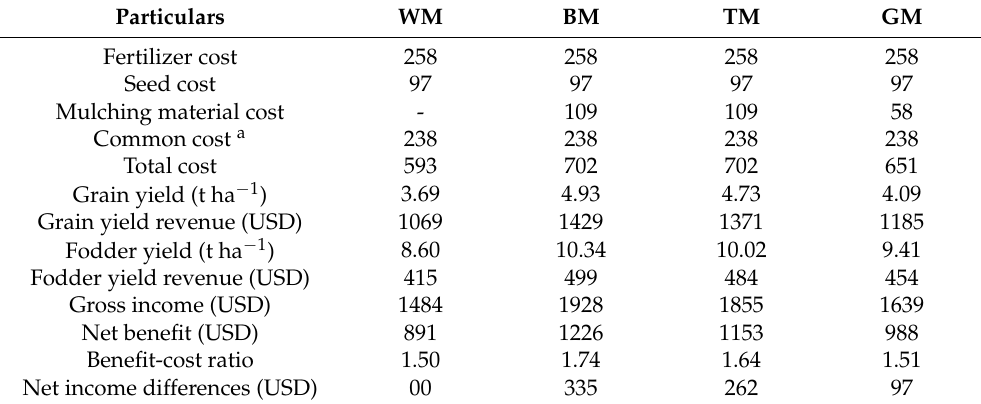
Table 4. Average economic benefit cost ratio (USD ha − 1 ) of maize production in 2017 and